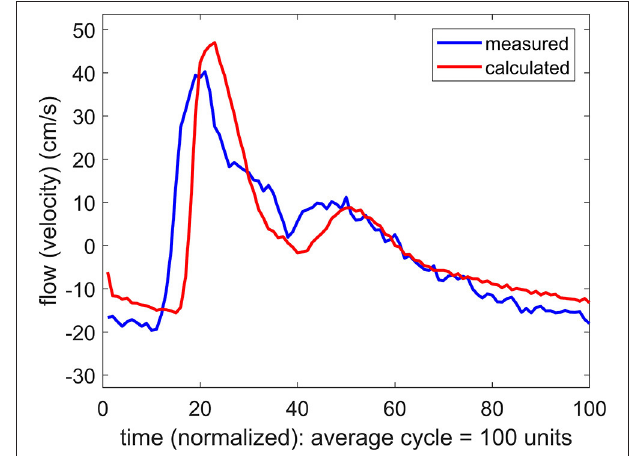
FIGURE 2 | Comparison of measured and calculated flow (velocity) waveforms in the vascular bed of the forearm, based on a pressure waveform measured simultaneously with the flow waveform at the brachial artery.